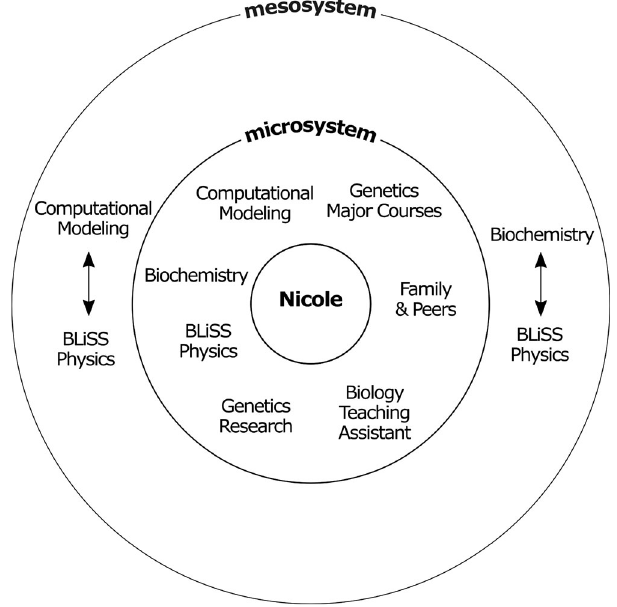
FIG. 5. Nicole ’ s microsystem and mesosystem. This figure represents the important settings, roles, and relationships in Nicole ’ s microsystem as well as connections across these elements in her mesosystem. This represents the subset of elements related to Nicole ’ s view of the relevance of physics, and is not meant to be a comprehensive accounting of Nicole ’ s